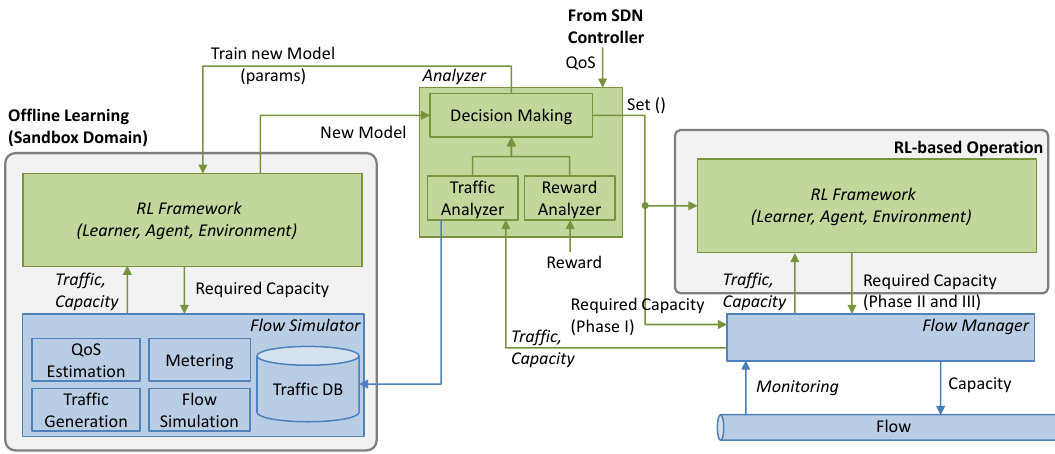
Figure 3. Extended architecture for flow capacity autonomous operation with offline learning.